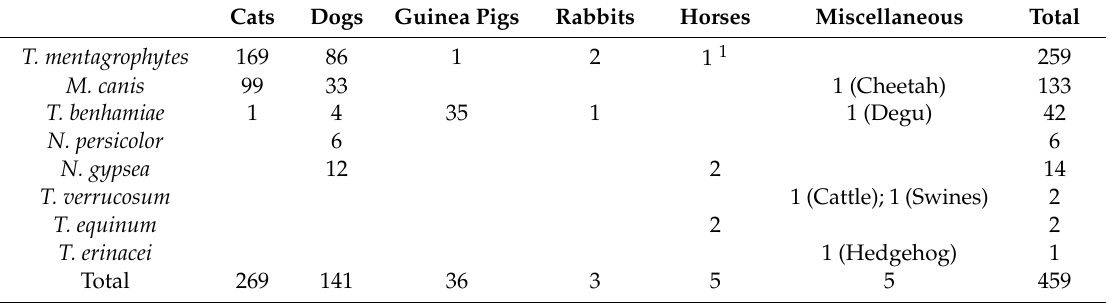
Table 2. Dermatophytes isolated in Lausanne from animal samples collected by veterinarians between 2008 and 2019. Cats Dogs Guinea Pigs Rabbits Horses Miscellaneous Total T. mentagrophytes 169